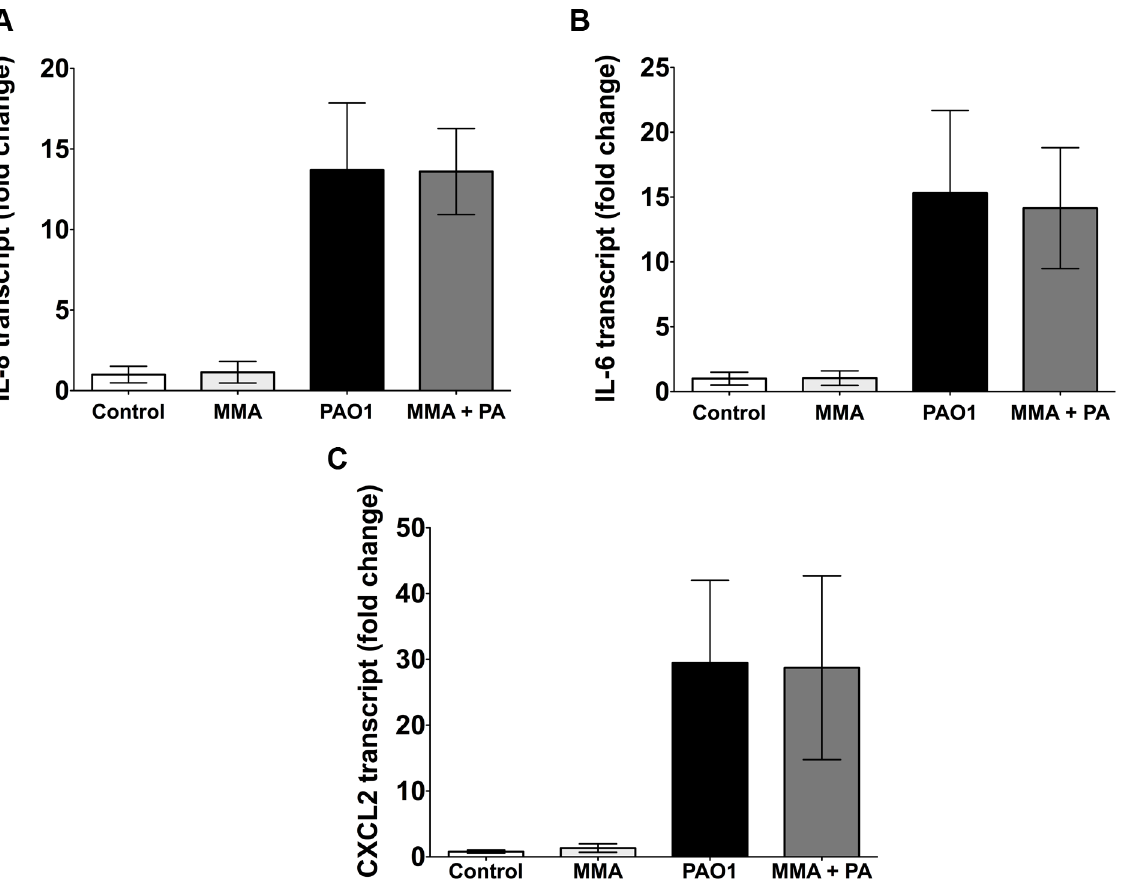
Fig 7. MMA III had no effect on cytokine mRNA levels. MMA III (5 ppb) had no effect on (A) IL-8 or on (B) IL-6 mRNA levels. In addition, MMA III (10 ppb) had no effect on (C) CXCL2 mRNA levels. Thus, the observed increases in IL-8, IL-6 and CXCL2 cytokine levels induced by MMA III were not related to increased mRNA levels. n = 4